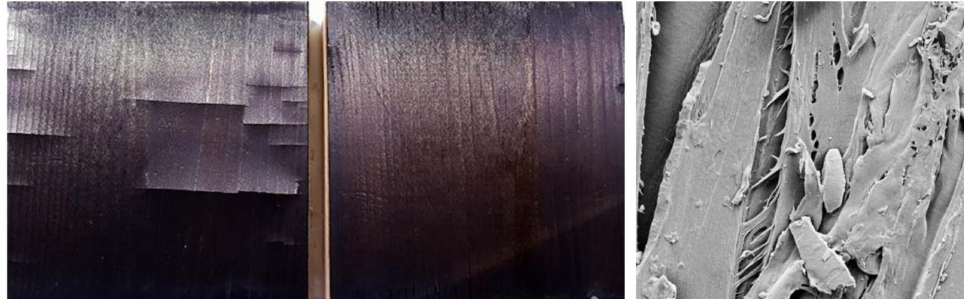
Figure 2. Samples DS60 with and without shallow surface checks pictured directly after modification. SEM image shows ruptured tracheid walls at 1000 ×